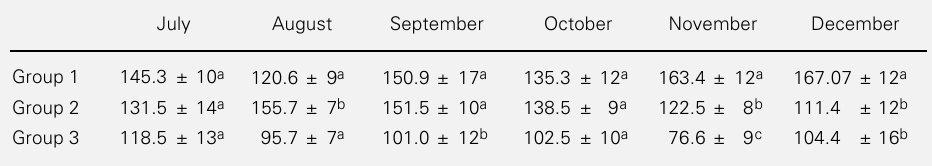
Table 1 - Comparison of monthly mean cortisol levels for three groups of Thoroughbred fillies of different ages and submitted to different periods of